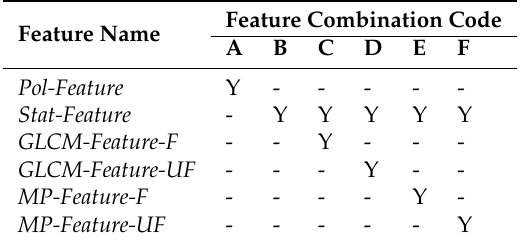
Table 5. Experiments settings regarding feature combinations.